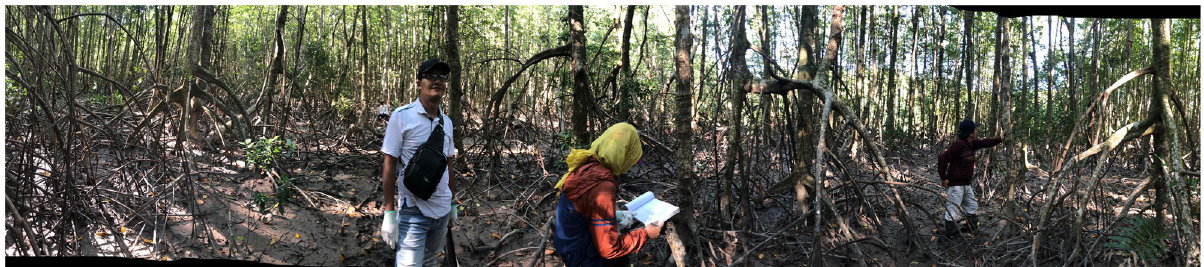
Fig 2. The survey in a sampling plot in the study area (Source: Photo taken by Pham Minh Hai (the author) in the study area in 2019).